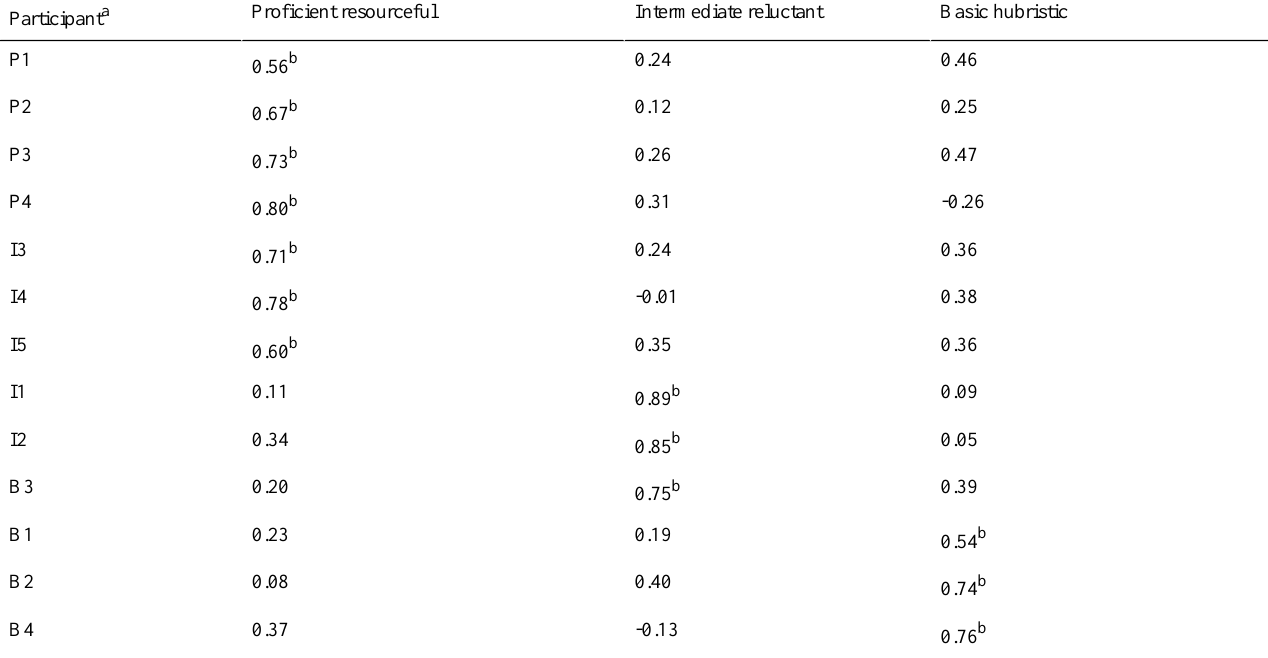
Table 3. Factor pattern/structure coefficients for